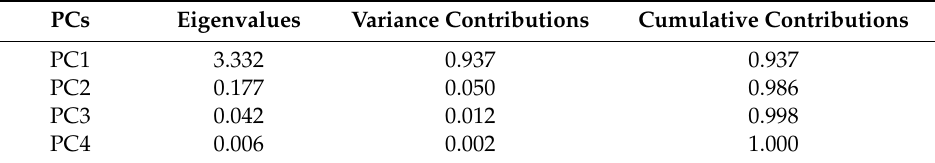
Table 2. The characteristics of eigenvalues and principal components (PCs).